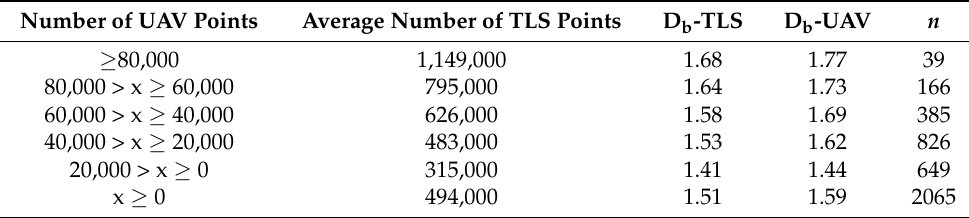
Table 8. Detected Scots pine trees ( n = 2065) are divided into five classes according to the number of measured points of unmanned aerial vehicles (UAV). The average number of terrestrial laser scanning (TLS) measured points in each class was consistent with UAV points.